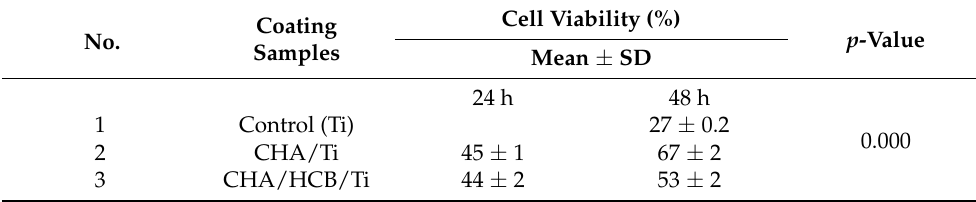
Figure 3. Surface morphology of coatings with an immersion time of 30 min. ( a ) CHA/Ti and ( b ) CHA/HCB/Ti (the white arrows indicate surface morphology), and ( c ) cell viability assay of coating samples after being incubated for 24 h and 48 h (*: p < 0.05). Table 2. Average Cell Viability of CHA/Ti 30 min and CHA/HCB/Ti 30 min.